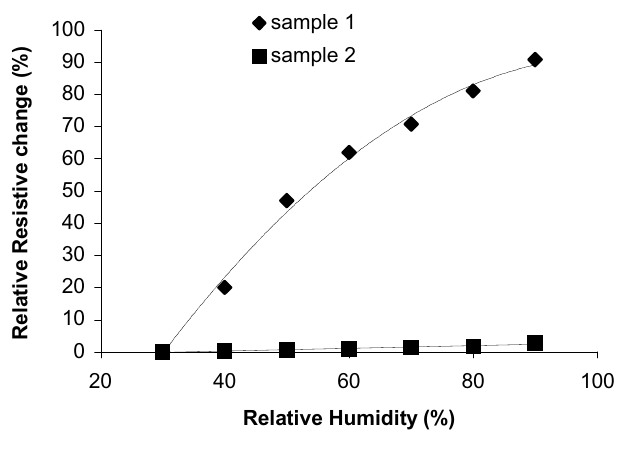
Figure 4. Variation in relative resistance ∆ R of the samples as a function of the increasing relative humidity values, at 30 o C.